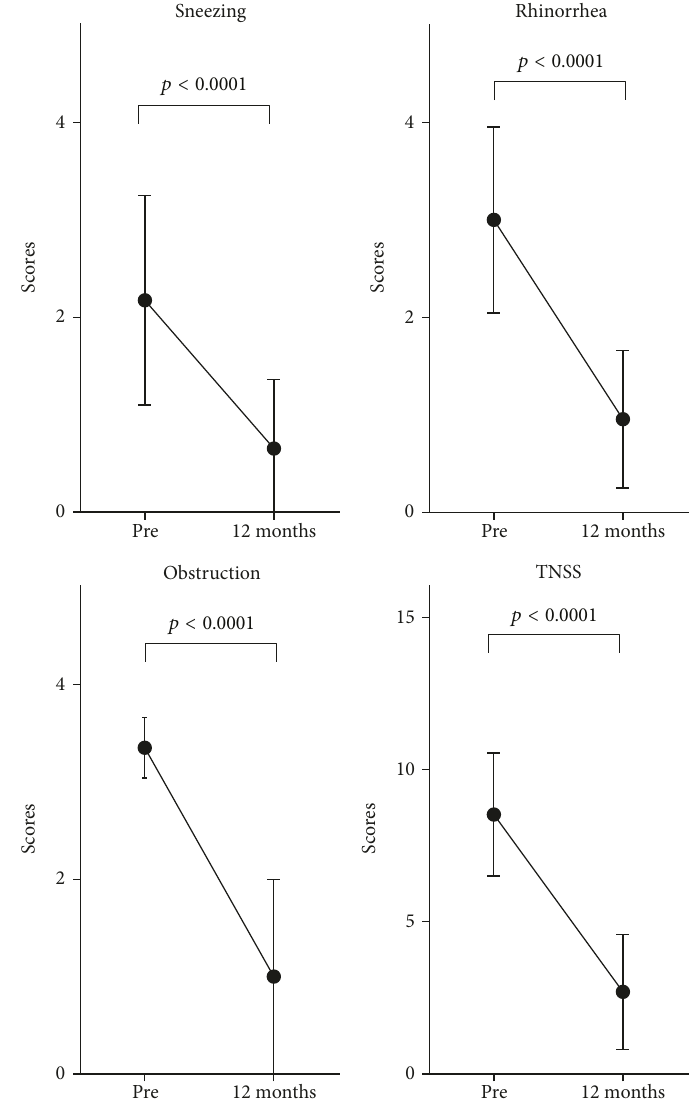
Figure 3: Changes in each nasal symptom and the total nasal symptom score (TNSS) after surgery ( 𝑛 = 23 ). The data were examined with the Wilcoxon signed rank test. Symbols and error bars represent mean values with standard errors. Pre =